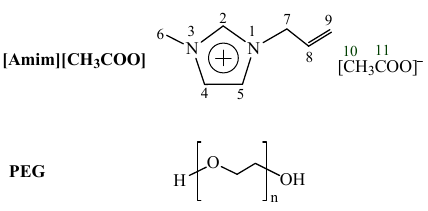
Figure 1. Schematic structure and carbon numbering of [Amim][CH 3 COO] ( upper ) and PEG ( below ). Table 2. The 13 C NMR chemical shifts ( δ (ppm) relative to TMS) of [Amim][CH 3 COO] in [Amim][CH 3 COO]/PEG-10 solvent and [Amim][CH 3 COO]/PEG-10/cellulose(8%) solution at room temperature.